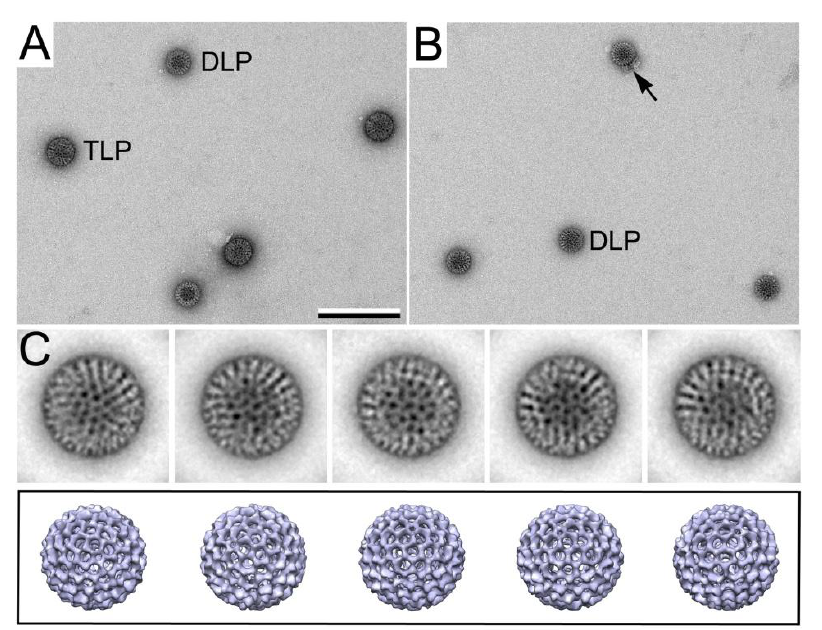
Figure 5. ( A ) EM images of viral triple-layered particles (TLPs) and DLPs adsorbed to glow-discharged SiN microchips in the presence of 1 mM EDTA and ( B ) 2 mM EDTA. Some globular outer capsid proteins remained on the DLPs during the conversion step (black arrow, B ). Scale bar is 200 nm. ( C ) Class averages (top panel) and 3D reconstructions (bottom panel) of samples treated with 2 mM EDTA indicated a statistically significant population of particles were converted to DLPs. Panel length is 140 nm. The approximate diameter of the reconstructions is 80